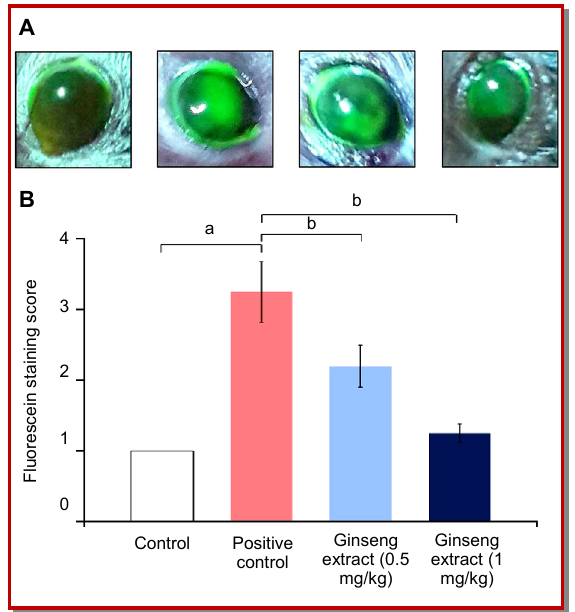
Figure 2: Clinical evaluation of dry eye including representa- tive images of corneal fluorescein staining (A) and staining scores (B) after 14 days and in the normal control. Results are expressed as mean ± SD for 4 mice per group ( a p<0.01, b